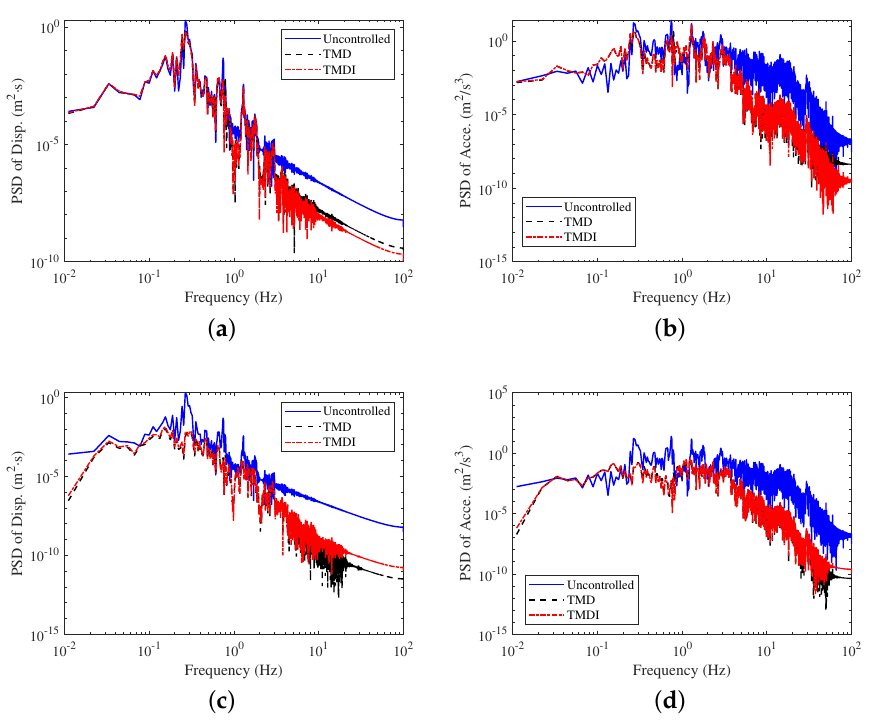
Figure 18. The PSD value of the top response of the main structure under earthquake of R2: ( a ) Top displacement under passive control; ( b ) Top acceleration under passive control; ( c ) Top displacement under active control; ( d ) Top acceleration under active